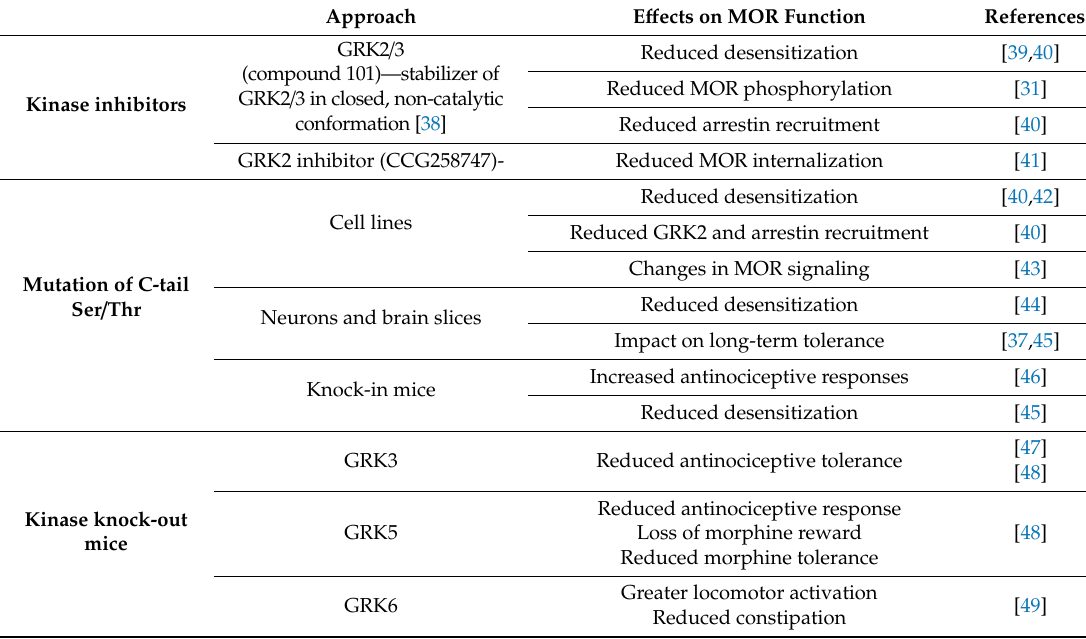
Table 1. Genetic and pharmacological approaches used to assess the roles of GRKs in MOR